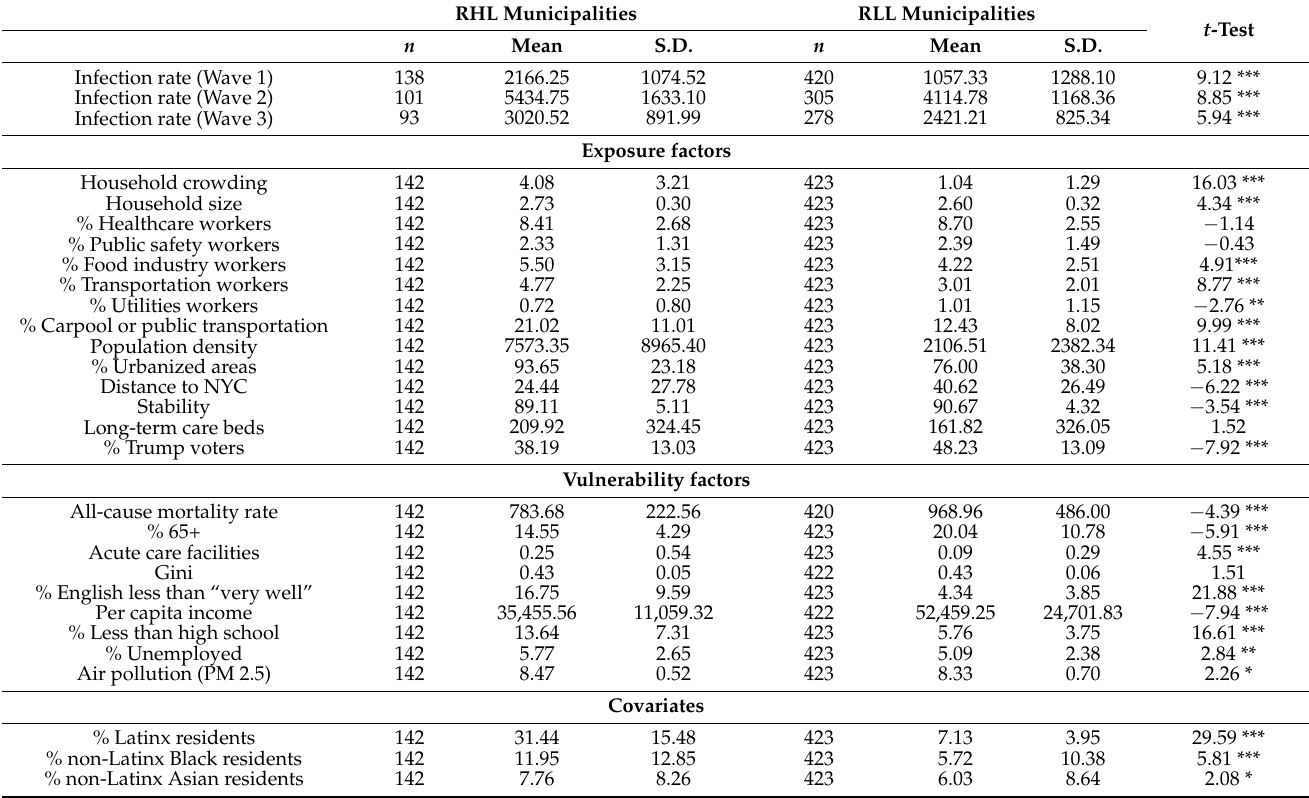
Table A2. Descriptive statistics by RHL and RLL